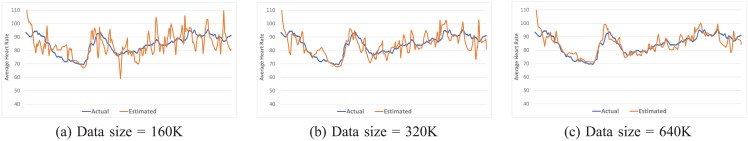
Actual vs. estimated stream of the average heart rates for varying data size (ϵ = 1.0).